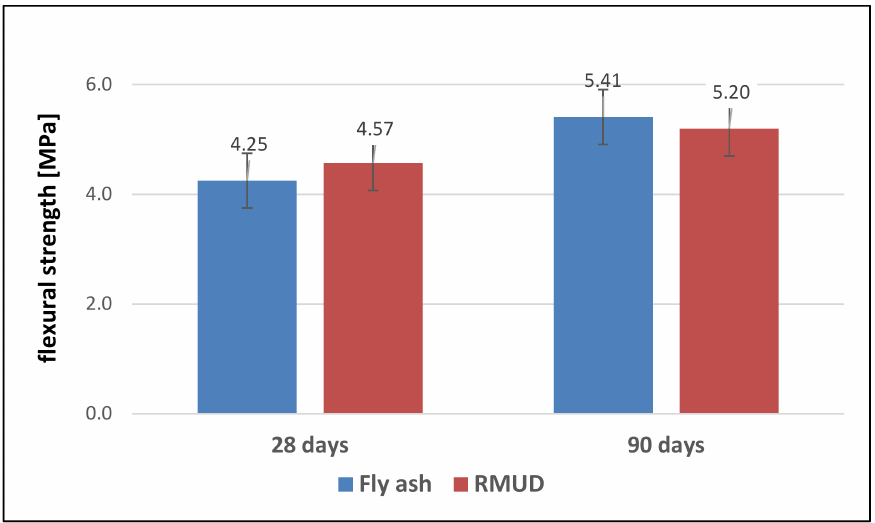
Figure 6. Flexural strength of